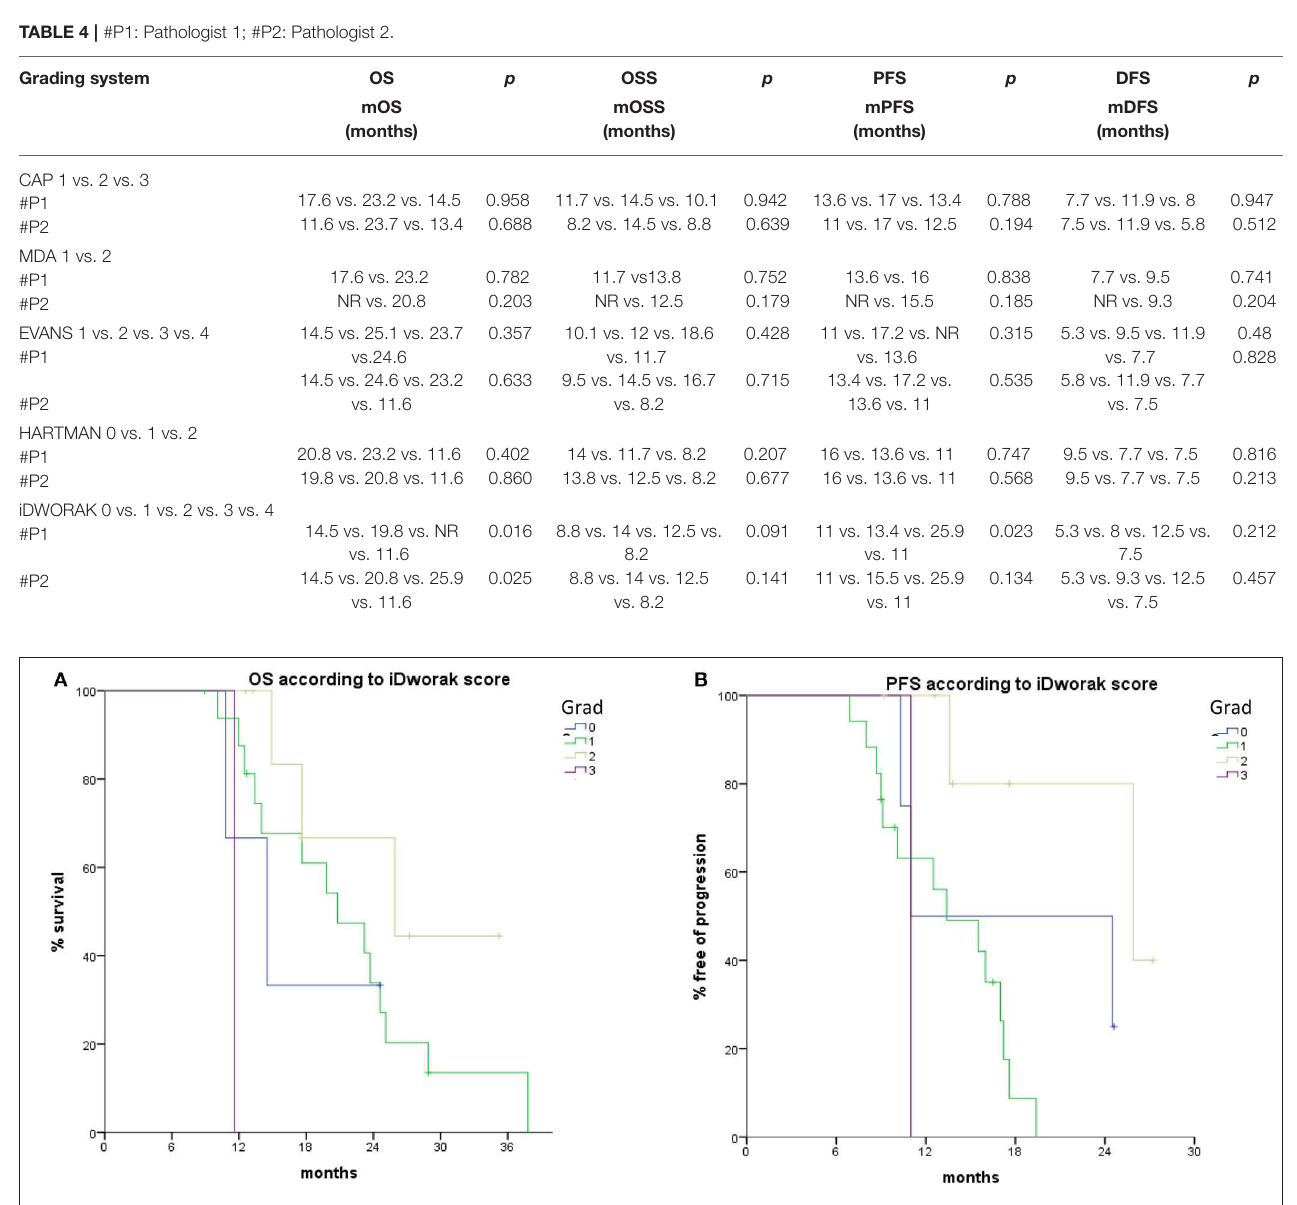
FIGURE 2 | Histopathologic treatment effect according to iDworak score is associated with improved (A) OS and (B) PFS. PFS, progression free survival; OS, overall